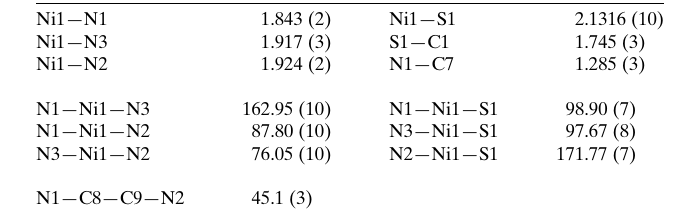
Table 1 Selected geometric parameters (A˚ , (cid:3) ) for 1 .